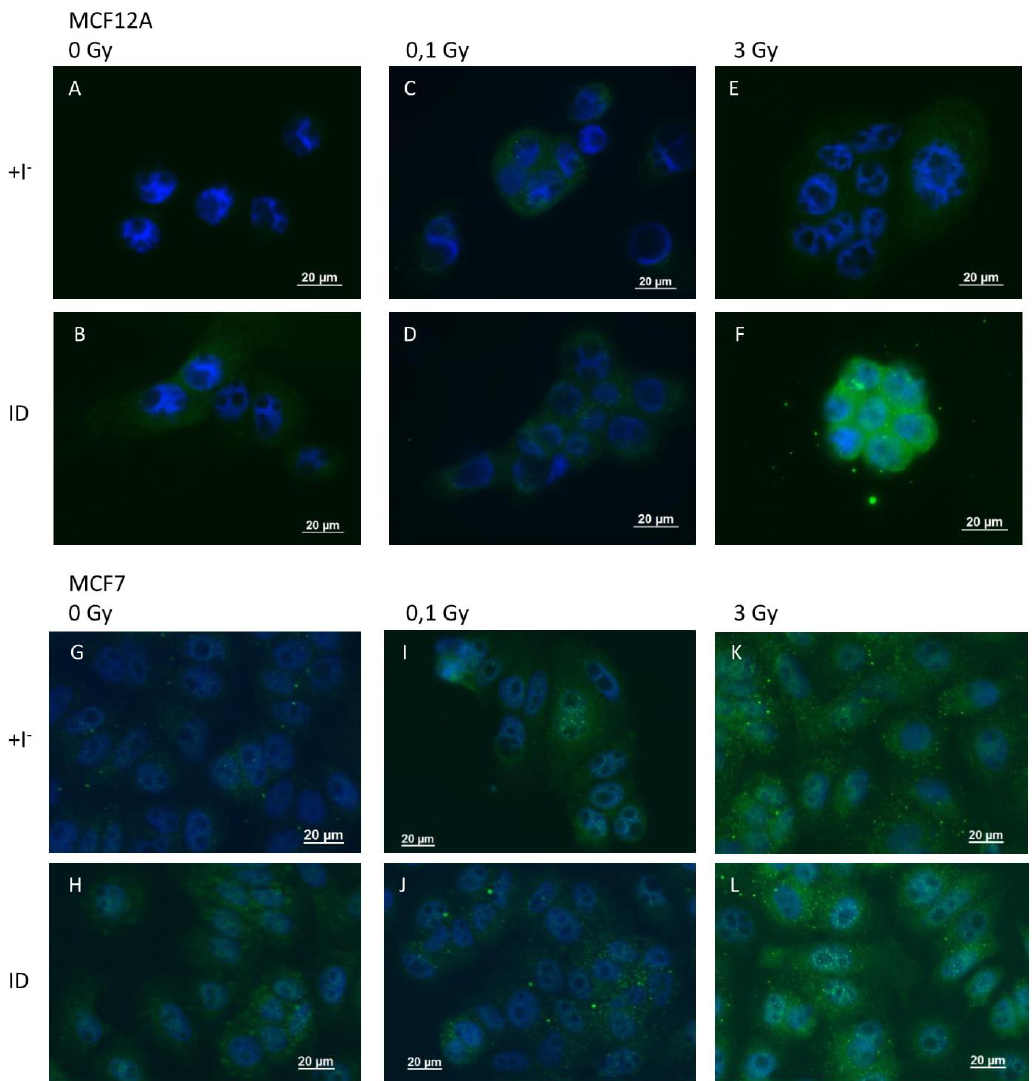
Figure 5. ID and X-irradiation increase oxidative stress (OS) in breast cells, with an additive effect at 3 Gy in MCF12A cells. Cells were cultured in iodine-containing medium for 7 days. Thereafter, the medium was replaced by iodine-containing (control) or iodine deficient (ID) medium and cells were then irradiated with a dose of 0.1 or 3 Gy. 4-HNE adducts were detected by immunofluorescence after 2 and 4 h in MCF12A ( A – F ) and MCF7 ( G – L ) cells respectively. Control (A, G), ID (B, H), 0.1 Gy (C, I), ID + 0.1 gy (D, J), 3 Gy X-rays (E, K) and ID + 3 Gy X-rays (F, L). Representative pictures are shown. Scale bars = 20 µm. N = 3.